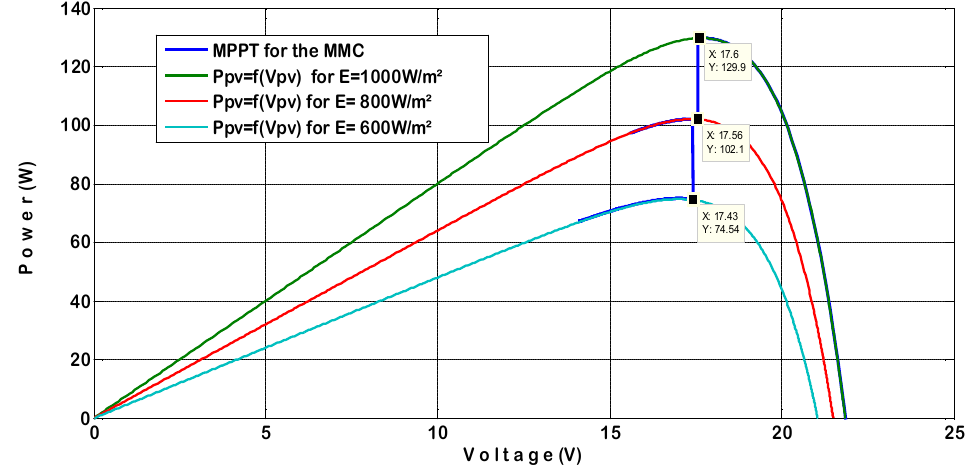
Figure 6. Trajectory of maximum power point of the photovoltaic generator.